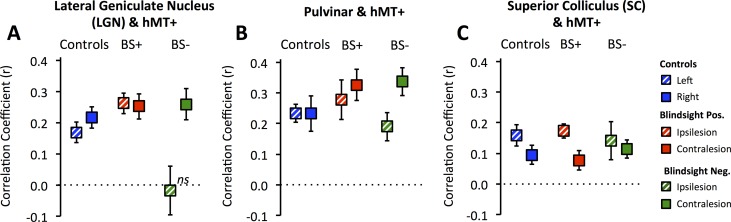
Functional connectivity of subcortical hMT+ pathways in patients and controls.(A) Correlation of LGN and hMT+. (B) Correlation of ventral pulvinar and hMT+. (C) Correlation of SC and hMT+. Box plots show Fischer-corrected mean correlation coefficients comparing each participant group ± SEM. Results are shown separately for the intact (solid boxes) and damaged hemispheres (striped boxes), and for left (striped) and right (solid) hemispheres in controls. Underlying data can be found in S3 Data. LGN, lateral geniculate nucleus; SC, superior colliculus; SEM, standard error of the mean.